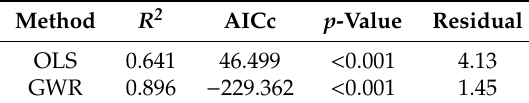
Table 3. Diagnostic statistic testing of geographically weighted regression (GWR) and